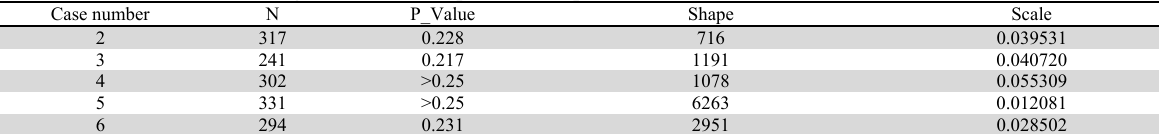
Outcomes of the Gamma fitting test for the competitors' bid